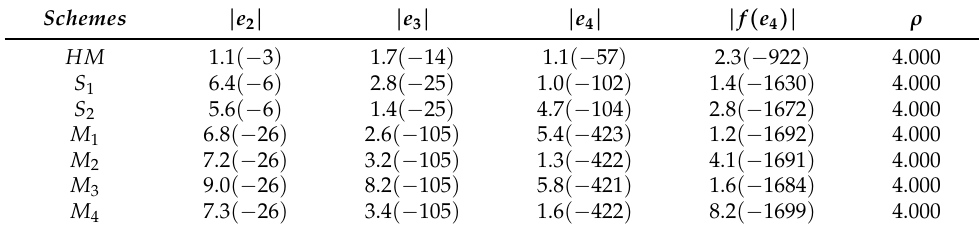
Table 2. Numerical results of function f 2